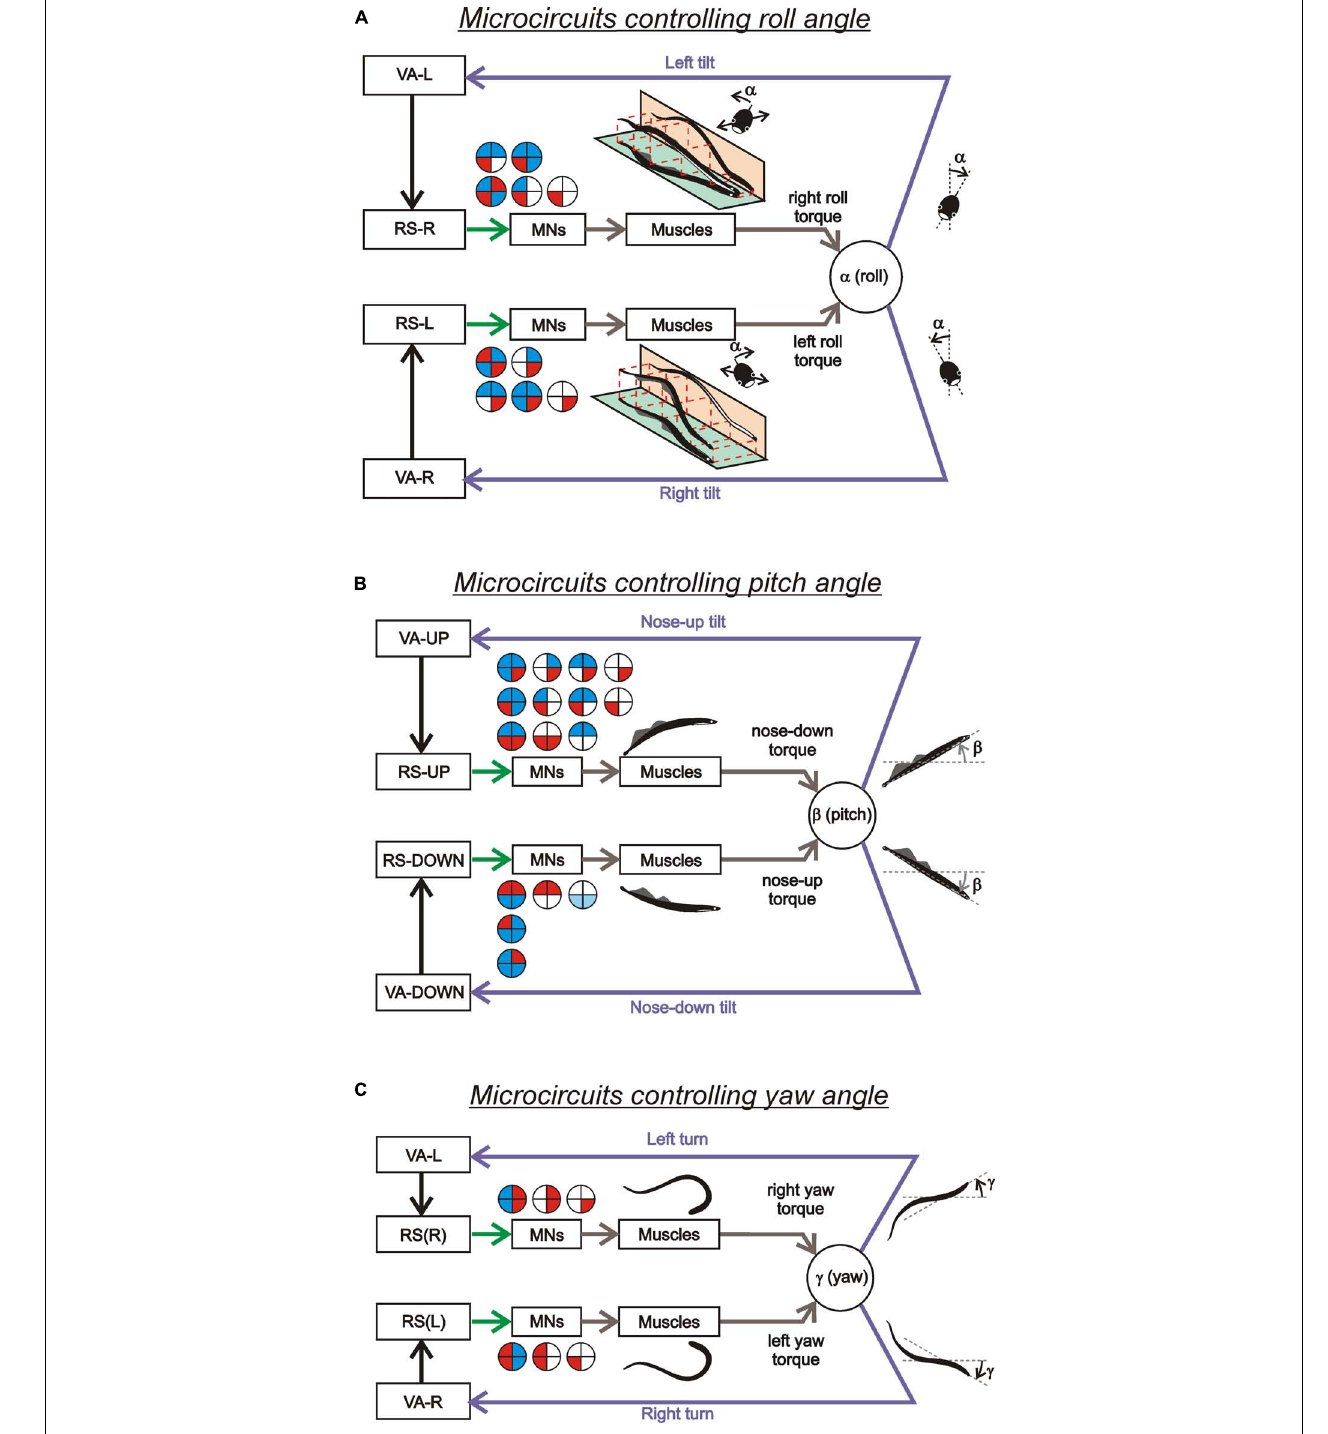
FIGURE 4 | Sensory-motor transformation in neuronal networks underlying operation of the roll, pitch, and yaw control systems. Relationships between vestibular responses and motor effects in individual RS neurons of the roll (A) , pitch (B) , and yaw (C) control systems.The neurons were divided into groups [RS-L, RS-R, RS-UP, RS-DOWN, RS(L), and RS(R)] according to their inputs (vestibular responses). For each group, the